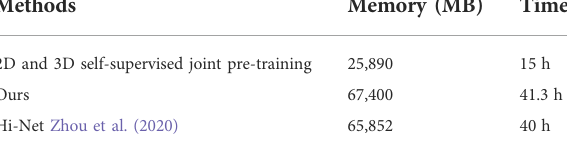
TABLE 6 Training cost comparison between our method and Hi-Net Zhouetal.(2020)onfourRTX3090GPUs,andthebatchsizeof3D volume is set to